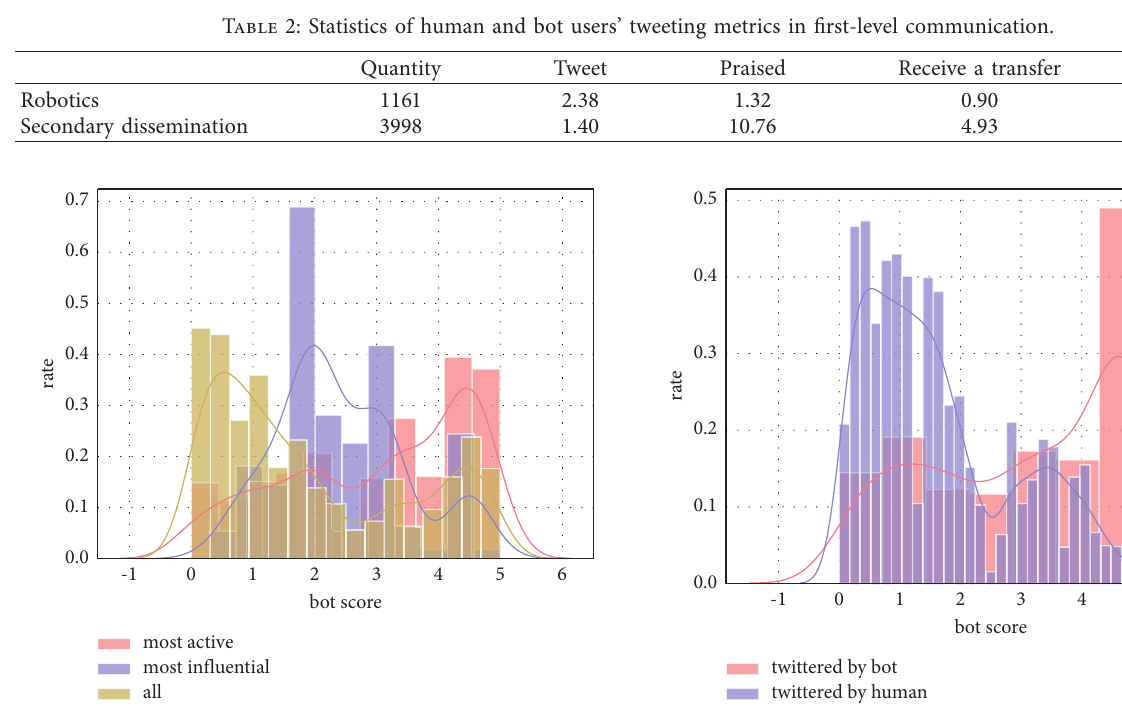
Figure 8: Conditional probability distribution of the bot scores of both sides of the forwarding